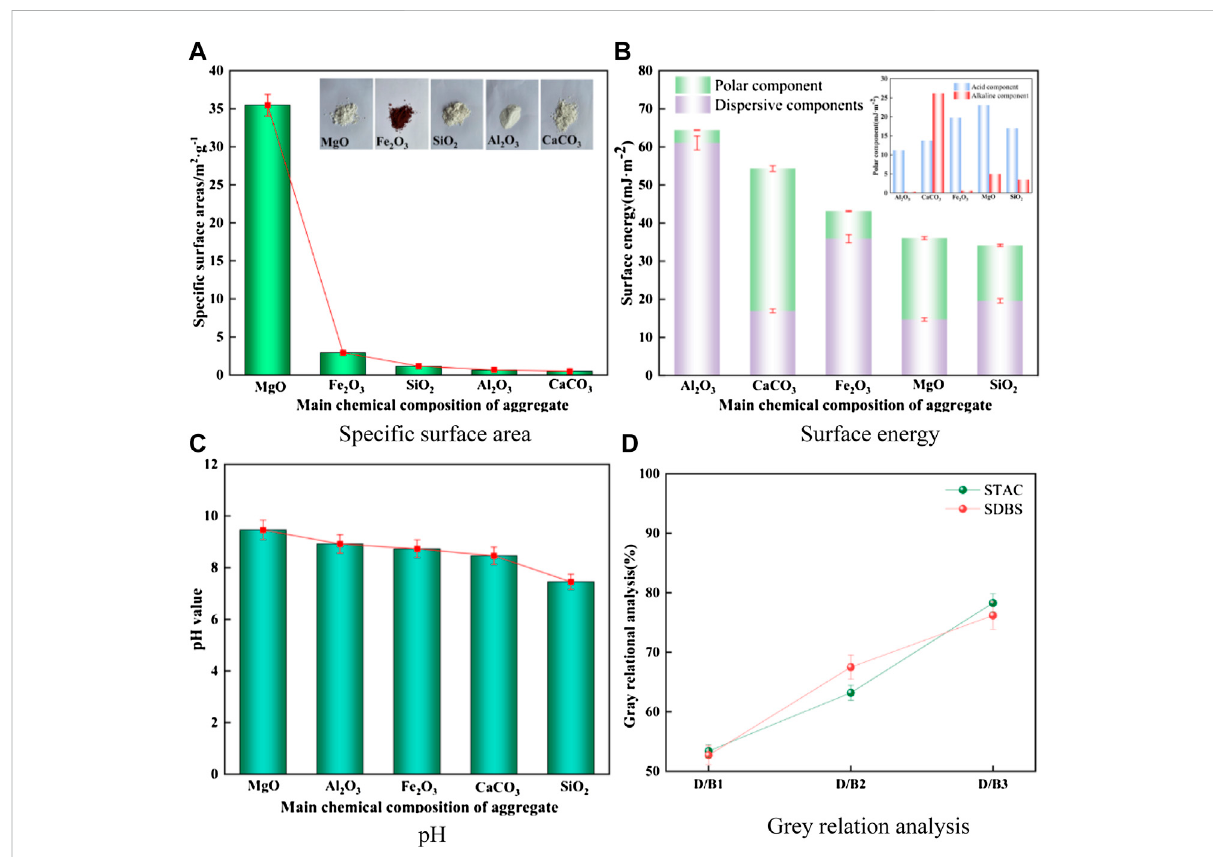
FIGURE 10 Aggregate physical properties and grey relation analysis. (A) Speci fi c surface area, (B) Surface energy, (C) pH test, (D) Gray relation